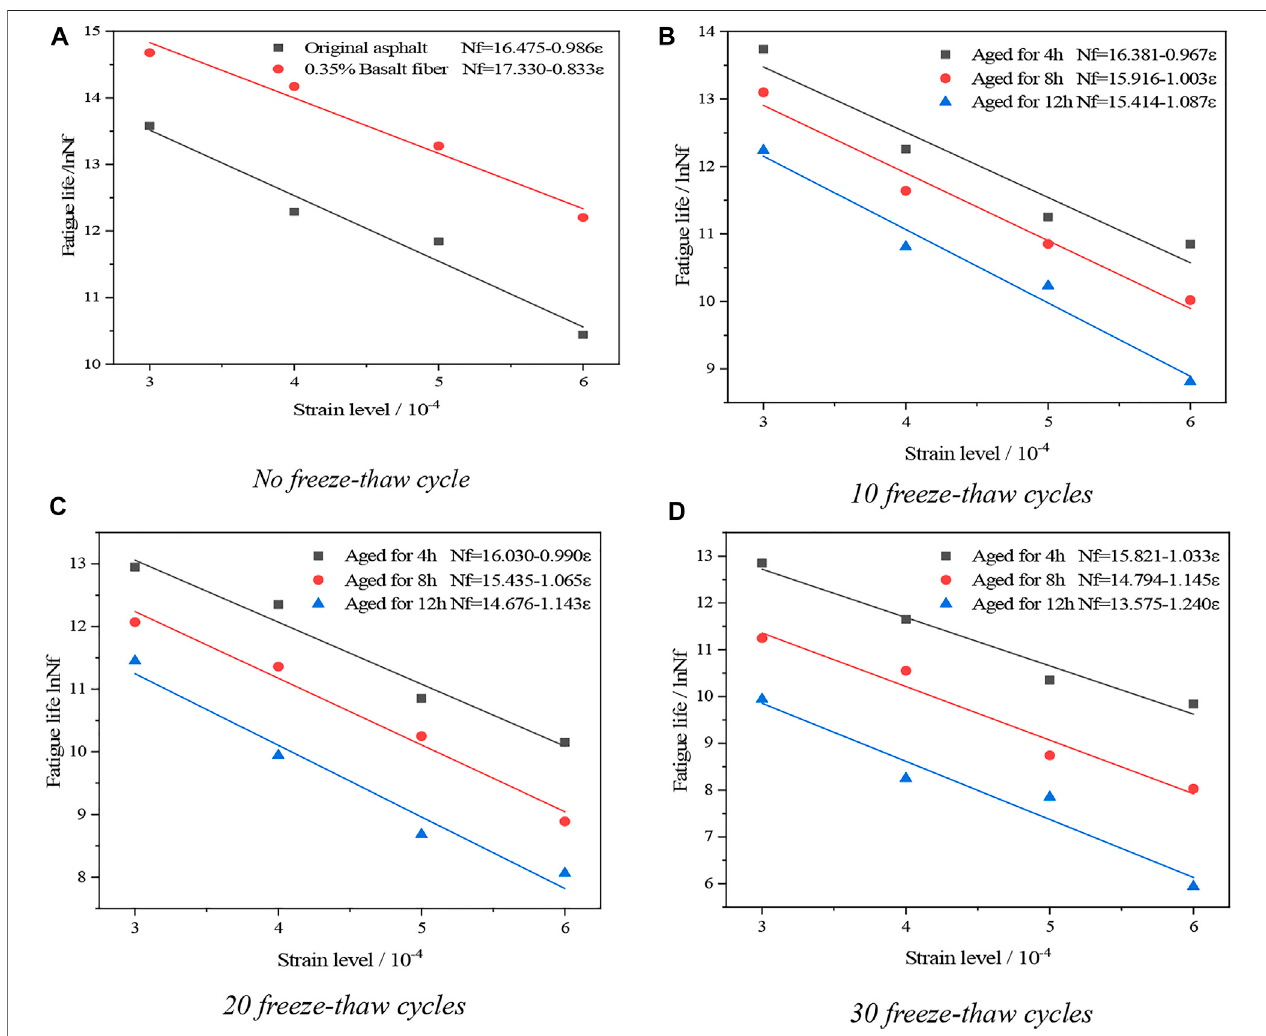
FIGURE 8 | Fatigue test results. (A) No freeze-thaw cycle; (B) 10 freeze-thaw cycles; (C) 20 freeze-thaw cycles; (D) 30 freeze-thaw cycles.